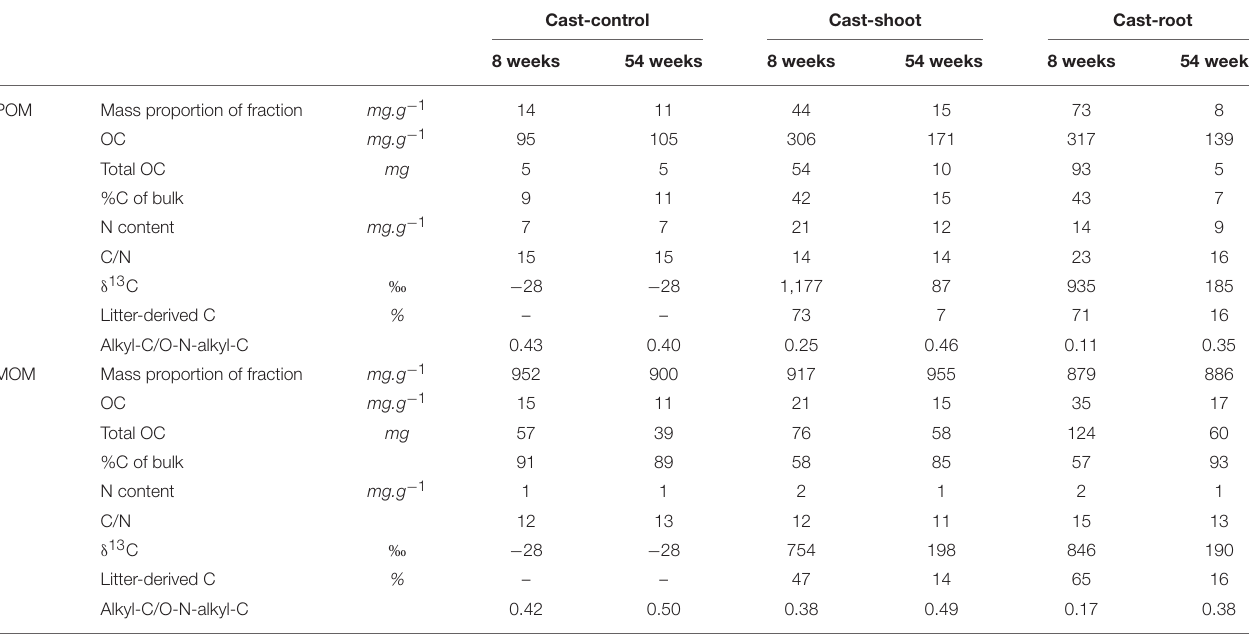
TABLE 2 | Organic carbon, nitrogen, δ 13 C and chemical characteristics of particulate organic matter (POM) and mineral associated organic matter (MOM) fractions isolated from earthworm casts.